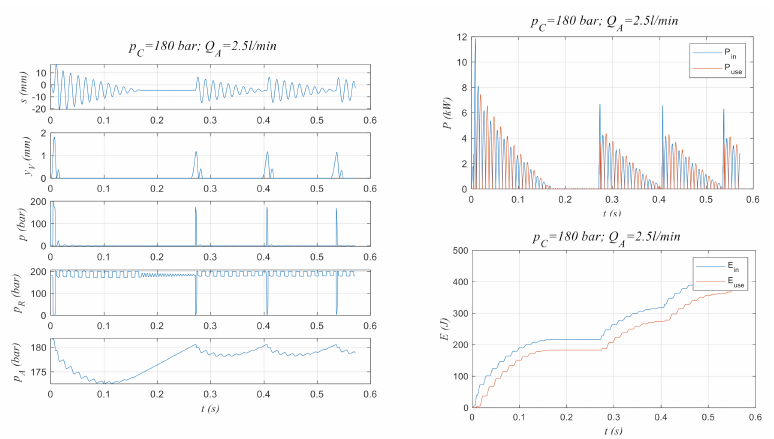
Figure 11. Results plots for p C = 180 bar, Q A = 2.5 L/min; s: piston position; y V : position valve spool; p, p R , p A : pressures in cylinder chambers and in entry side capacitance; E in , E use : input and recuperated